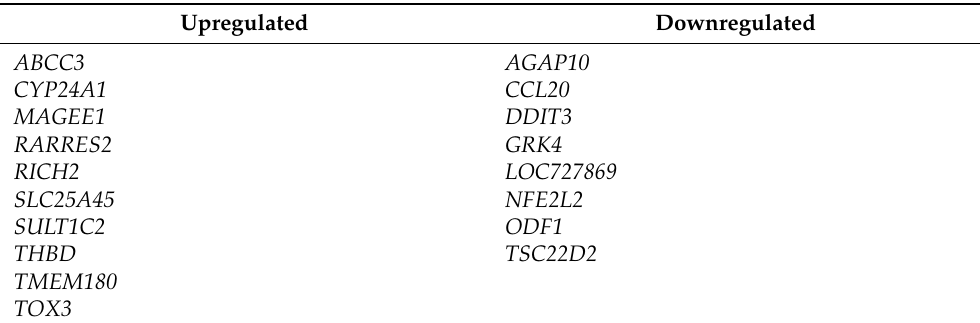
Table 2. Gene symbols of transcripts that are 2-fold upregulated or downregulated in both the pre-mineralization and mineralization phases of human osteoblasts (i.e., 10 and 8 in both phases in Table 1) *.